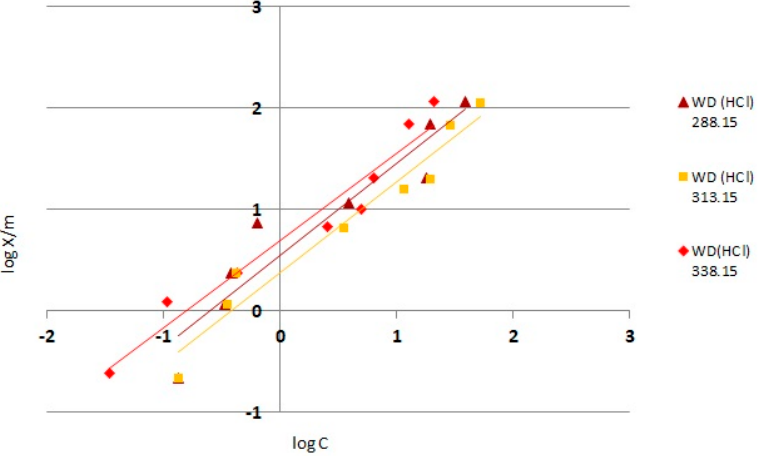
Figure 5. Freudlich adsorption isotherms for WD(HCl) at temperatures: 288.15; 313.15; 338.15 [K].